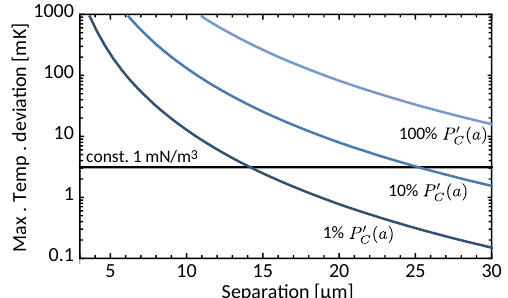
Figure 6. Maximum permissible thermal deviation of the sensor for a measurement of the Casimir pressure gradient at indicated precision or a constant pressure gradient sensitivity of